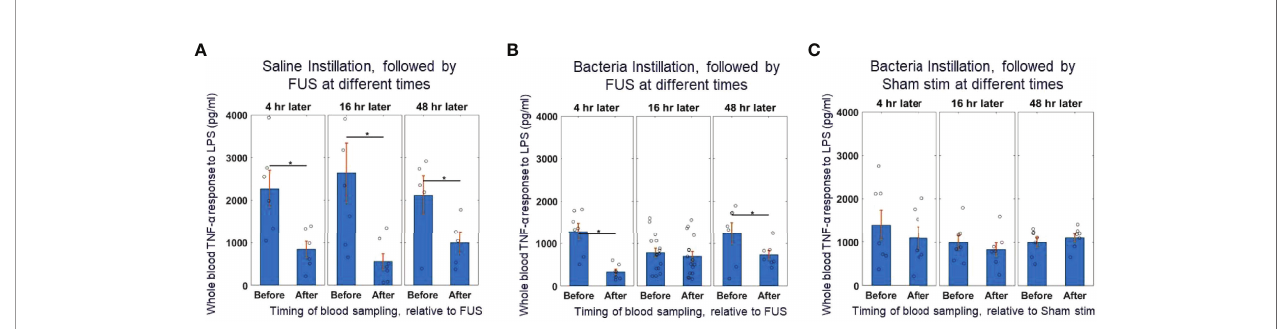
FIGURE 2 | Whole blood cytokine response assay to saline and bacteria instillation. (A) TNF- a response to in-vitro LPS challenge test (10 ng/ml) in instillation naïve animals (left bars) and saline instilled animals (middle and right bars) before and after splenic ultrasound stimulation at multiple timepoints. (B) TNF- a response to in-vitro LPS challenge test in bacteria instilled animals before and after splenic ultrasound stimulation at 4 hours, 16 hours, and 48 hours post- bacterial infection. (C) Same as (B) , but in sham animals (i.e, without active ultrasound stimulation). Asterisk indicates p <0.05 using non-paramteric Wilcoxon rank sum test. n=7 for all groups (except bacteria instillation + CAP activation which has n=13).